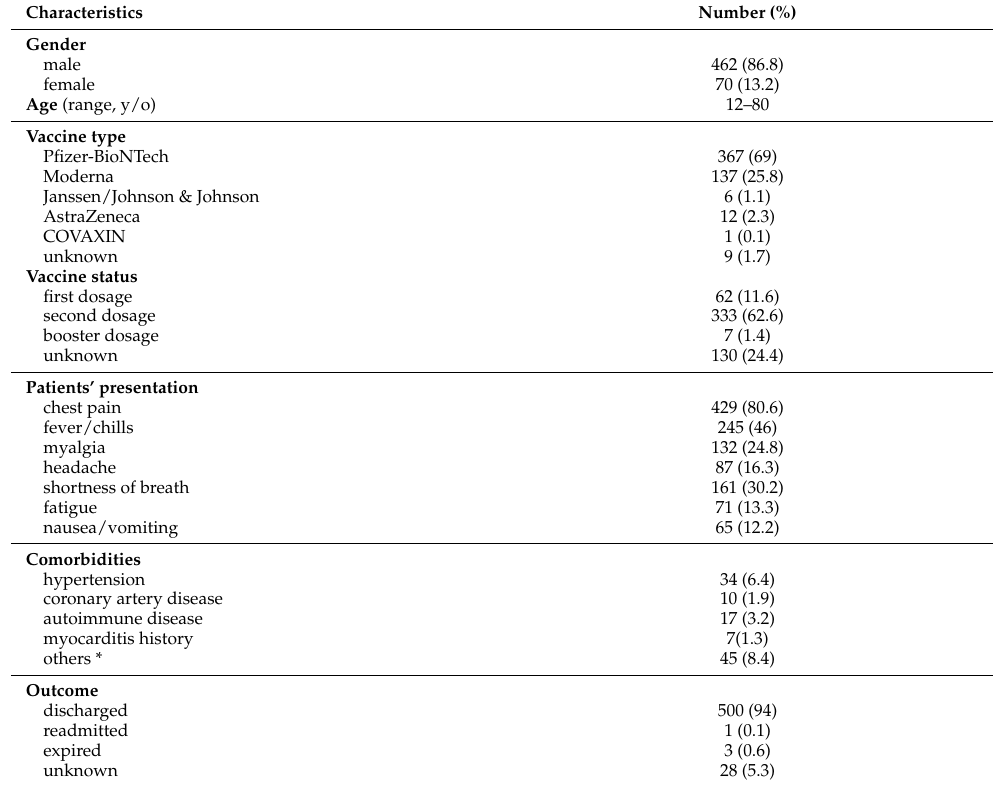
Figure 5. Flow diagram of the study selection process. Preferred reporting items for systematic reviews and meta-analyses (PRISMA). Adapted from Moher et al. Table 1. Characteristics of Cases with Myocarditis Following COVID-19 Vaccination ( n =